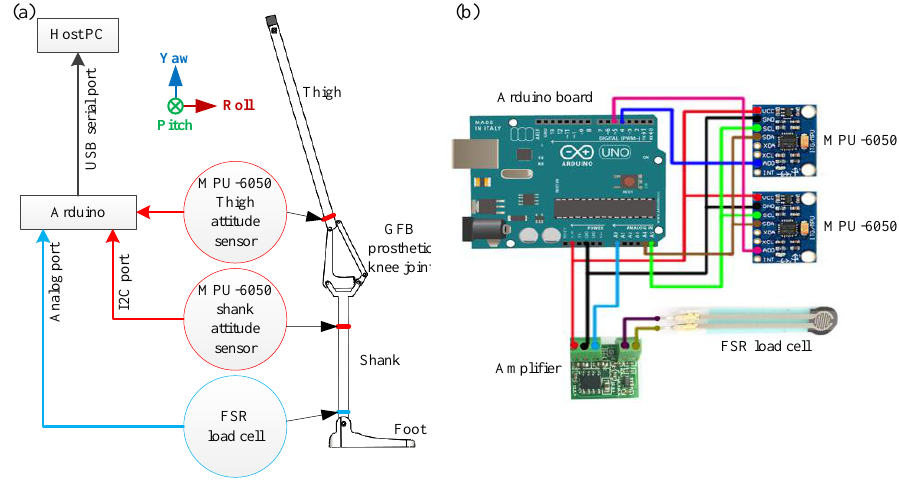
Figure 3. Attitude measurement platform: ( a ) schematic diagram; ( b ) hardware diagram.